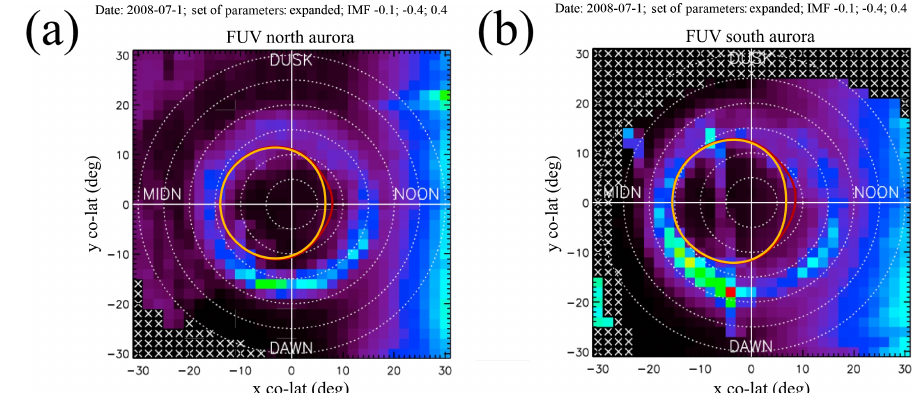
Figure 10. Comparison of the statistical UV auroral oval obtained by Carbary (2012) from Cassini UVIS data from 2007–2009 with model calculations of the open-closed field line boundary for (a) the northern and (b) the southern hemispheres. The model time was selected to be 1 July 2008 (the middle of the interval of Cassini observations), and the set of the model parameters corresponds to the expanded state of the magnetosphere, i.e., low solar wind dynamic pressure (see text). The northward-directed IMF vector assumed has components ( − 0.1, − 0.4, 0.4)nT. The red line marks the open flux boundary for the open model, while the orange line is for the partially closed model.